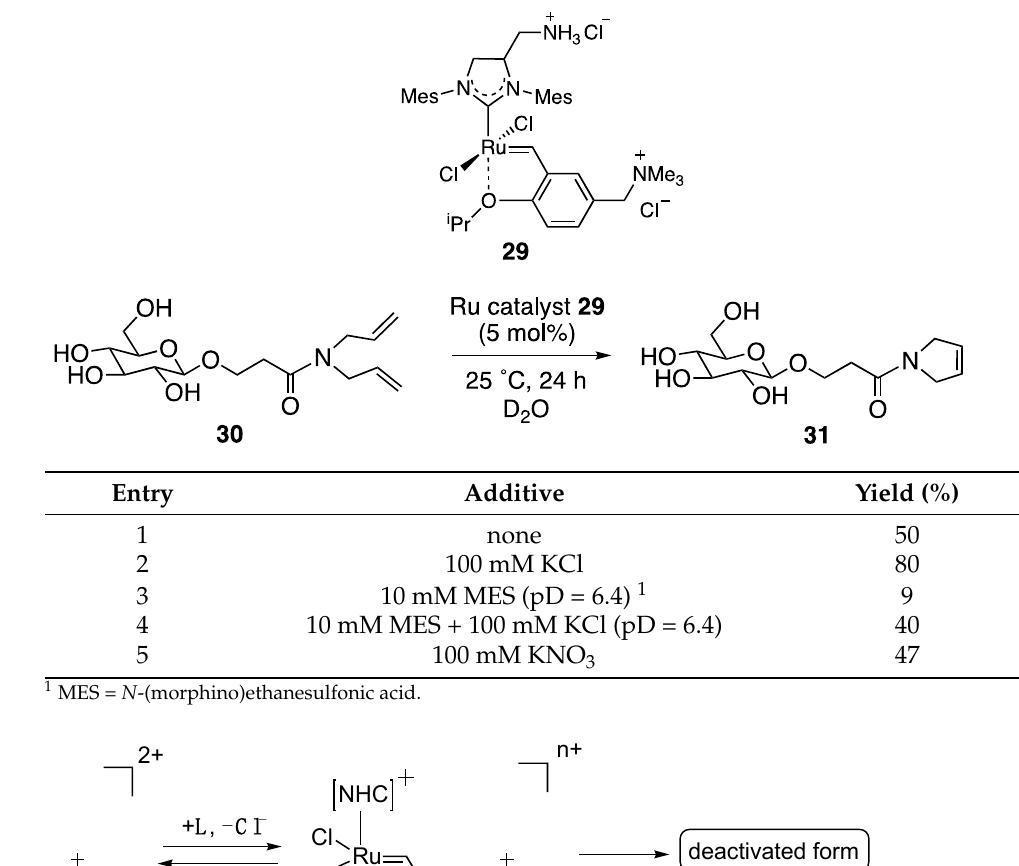
Table 3. Effect of additive salt on the yield of the RCM reaction [57].